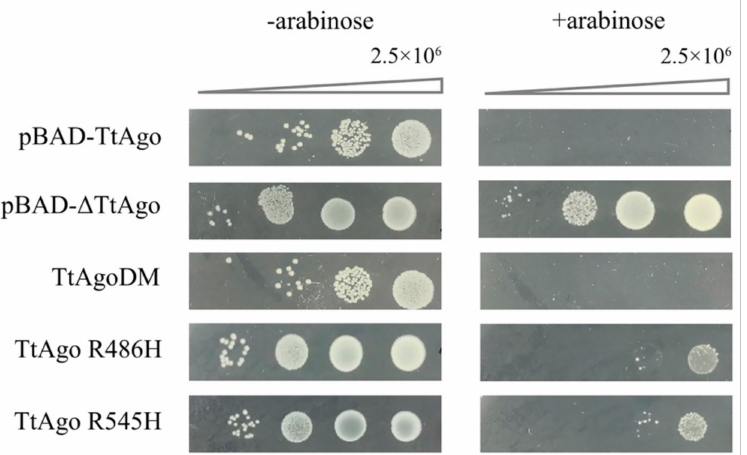
Figure 8. Colony spot plating assay for TtAgo point mutations. Colony spot plating assay for pET28a- pBAD-TtAgo, pET28a-pBAD- ∆ TtAgo, pET28a-pBAD-TtAgoDM, pET28a-pBAD-TtAgo (R486H), pET28a-pBAD-TtAgo (R545H), with and without L-arabinose induction. pET28a-pBAD-TtAgo represents intact TtAgo enzyme activity, and pET28a-pBAD- ∆ TtAgo represents enzymatic dead TtAgo activity. Three biological replicates were performed for each group. “-arabinose” represents without arabinose induction, “+arabinose” represents with arabinose